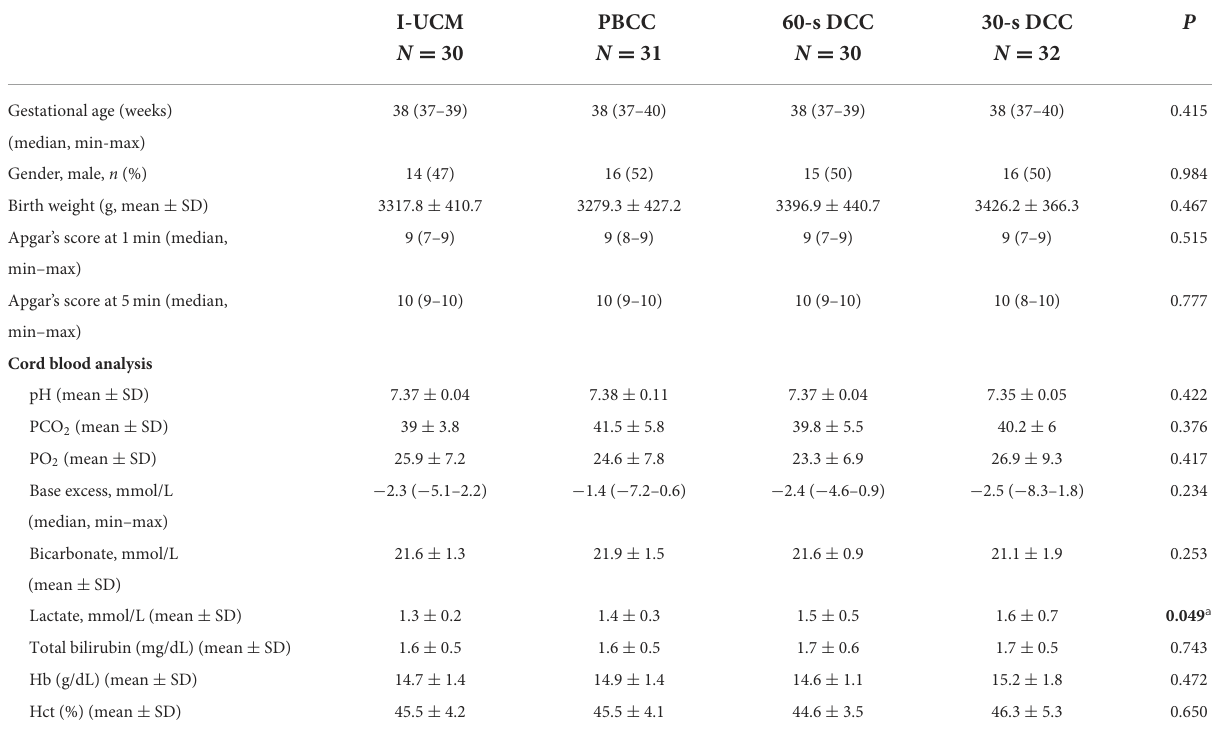
TABLE 1 The infants’ demographic and laboratory